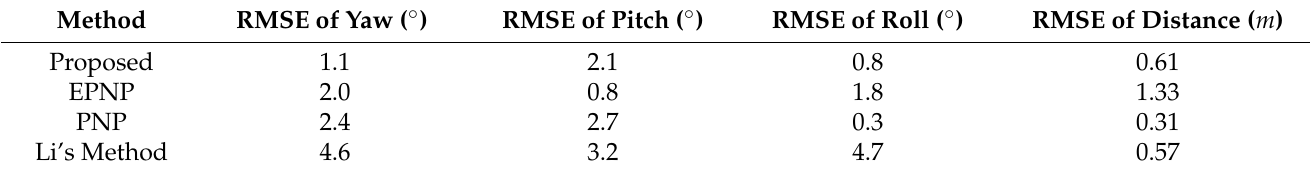
Table 3. RMS of attitude angle and depth distance in the comparison